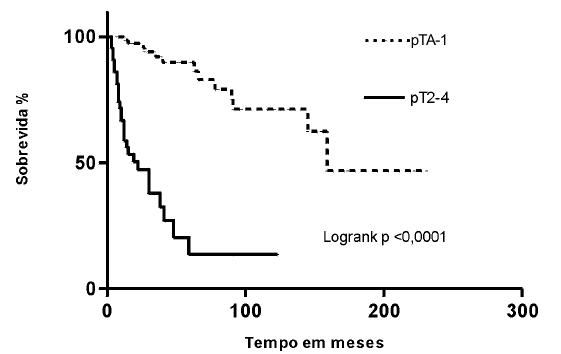
Figura 2 – Sobrevida dos pacientes em função do estádio da lesão